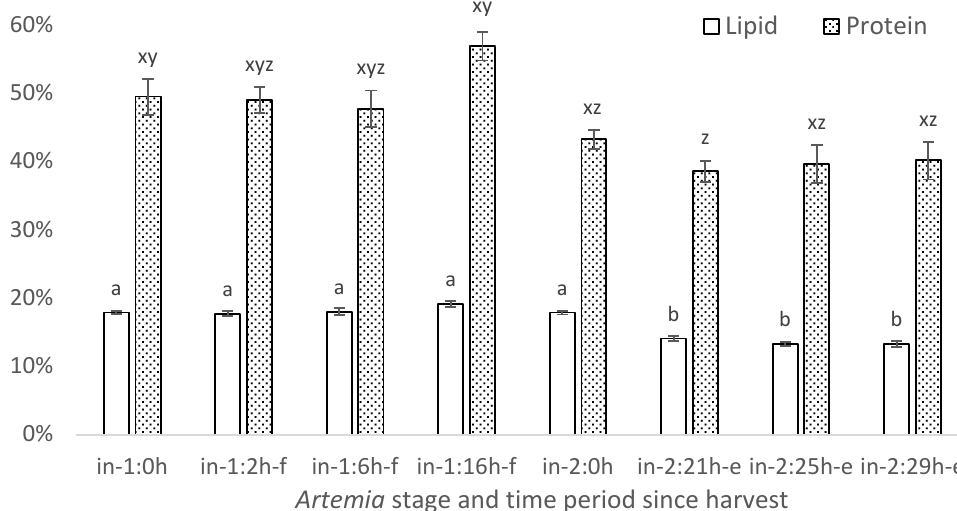
Figure 4. Mean lipid (no fill) and protein (shaded) proportions of Artemia as % dry weight. Annotations: in-1 refers to Instar-I Artemia and 0 h denotes immediately after harvest; 2, 6, and 16 h-f denote 2, 6, and 16 h in cold store, respectively. In-2 refers to Instar-II+ Artemia and 0 h immediate sampling on harvest; 21, 25, and 29h-e signify 21, 25, and 29 h enrichment, respectively. Means with different superscripts are significantly different among means for lipid and protein ( p < 0.05).